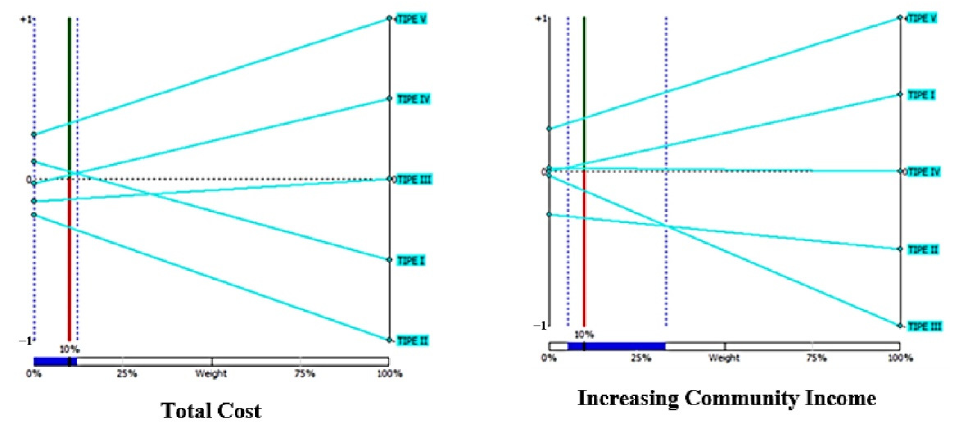
Figure 6. Sensitivity analysis (stability interval) for both criteria.